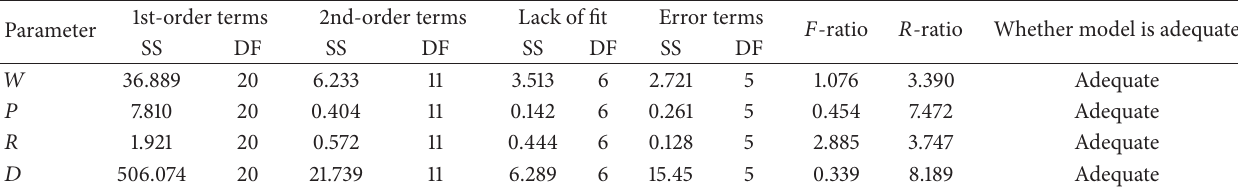
Table 5: Analysis of variance for testing adequacy of the model.